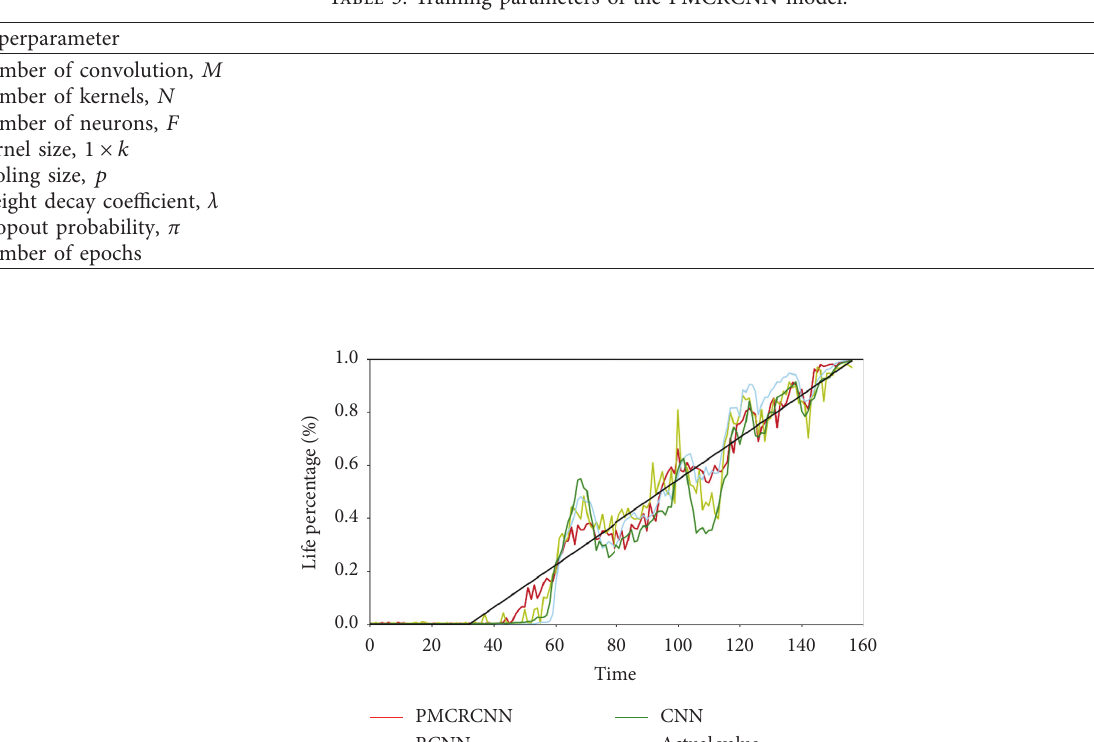
Table 3: Training parameters of the PMCRCNN model.